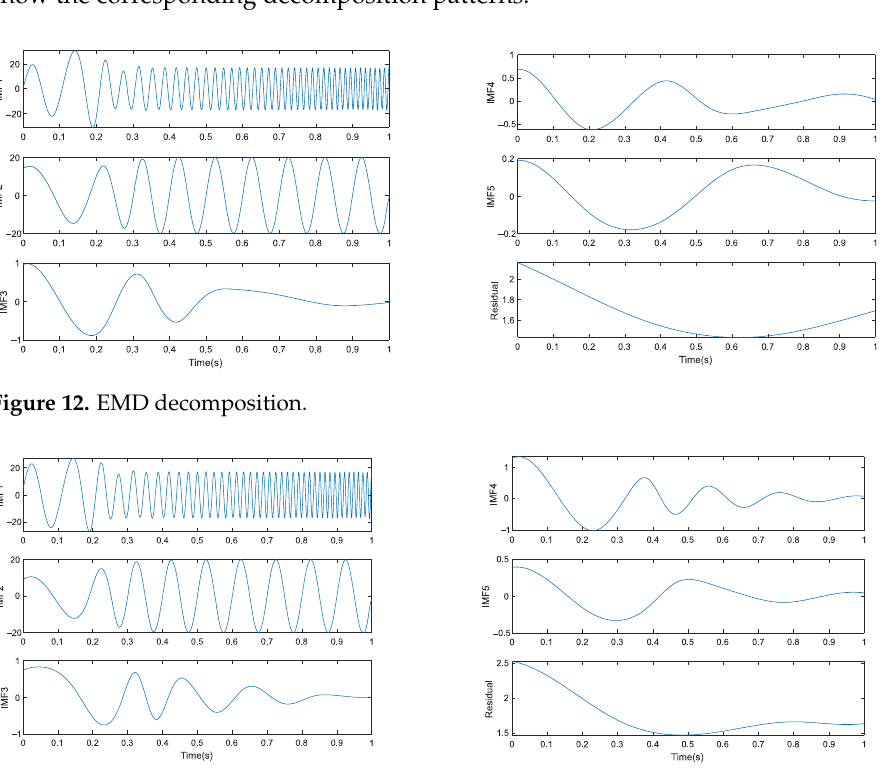
Figure 13. IEMD decomposition.